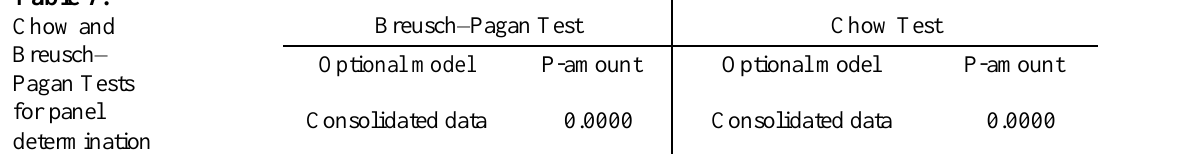
Table 7. Breusch– for